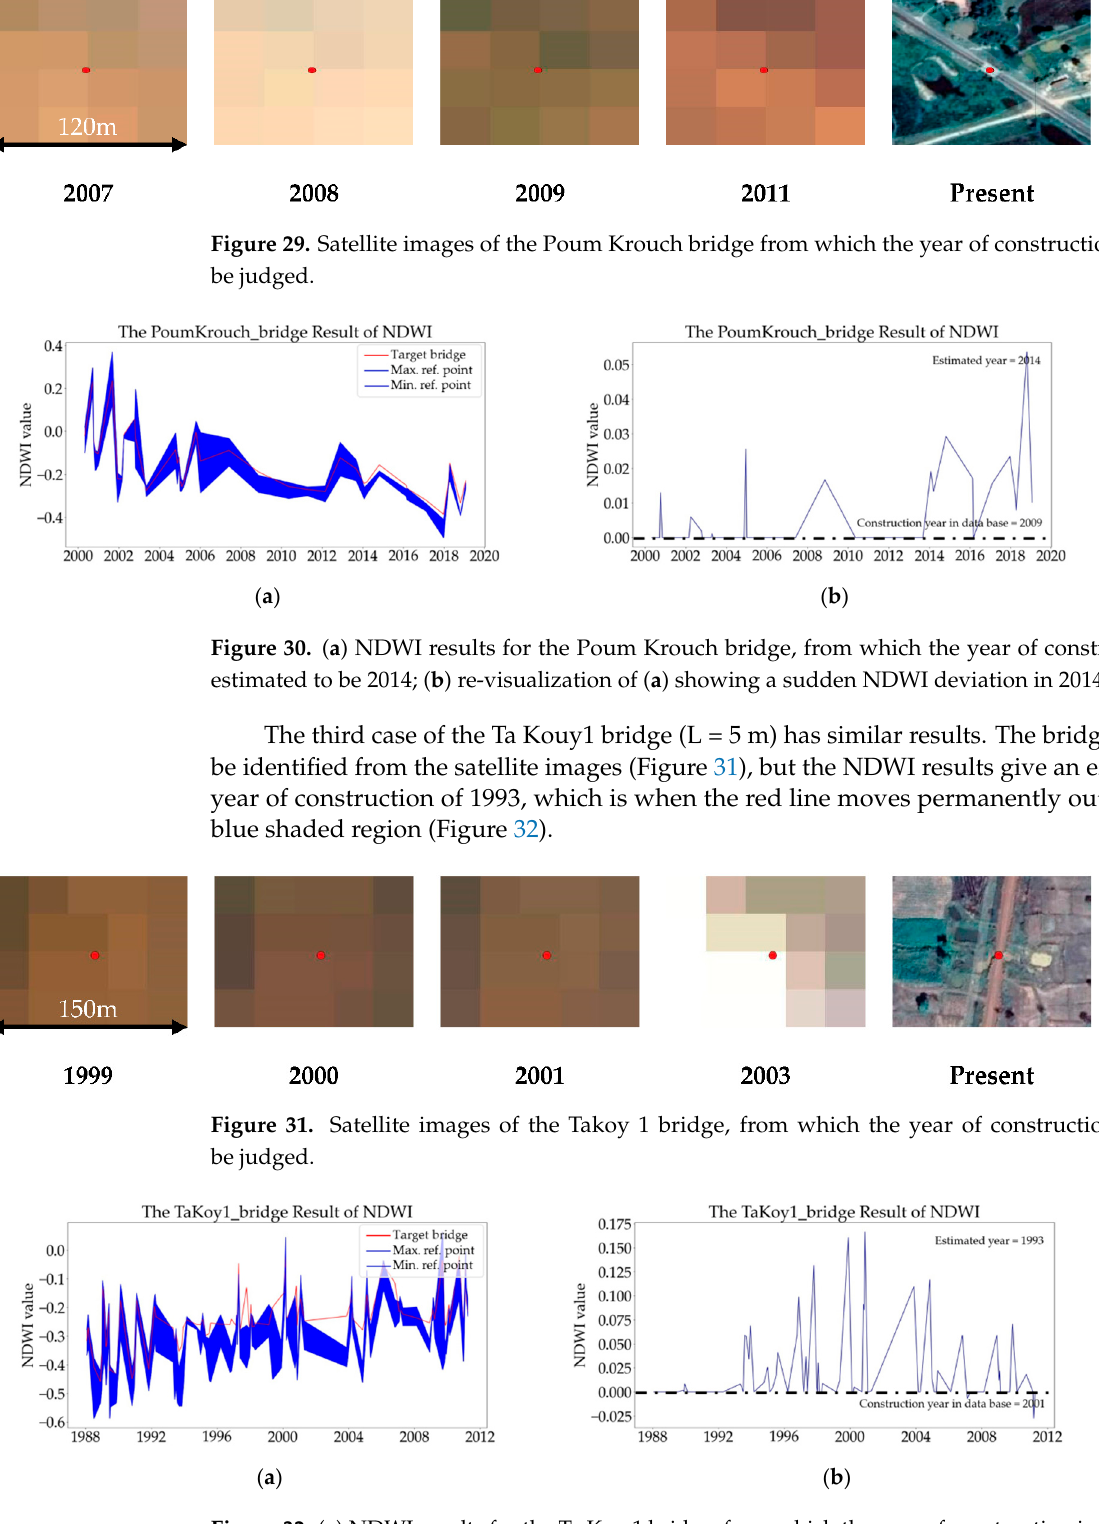
Figure 32. ( a ) NDWI results for the Ta Koy 1 bridge, from which the year of construction is estimated to be 1993; ( b ) re-visualization of ( a ) showing a sudden NDWI deviation in